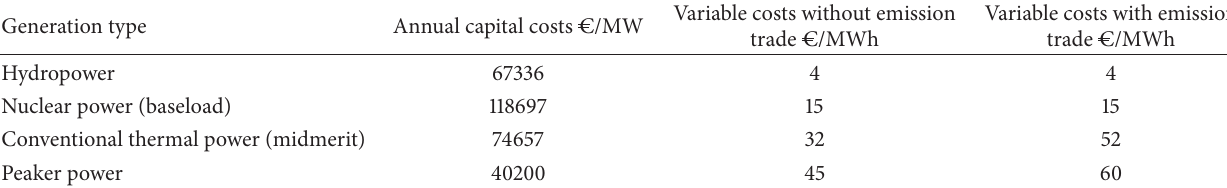
Table 1: Capacity and generation